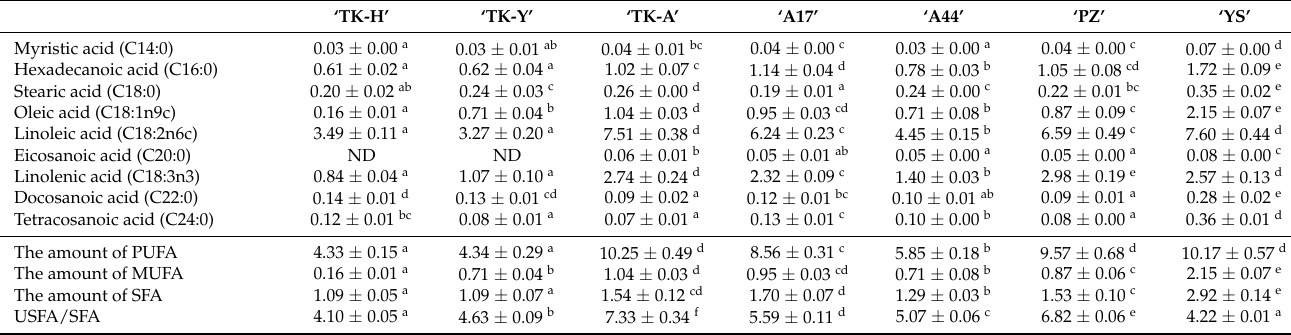
Table 2. Fatty acid contents (mg/g DW) in dandelion